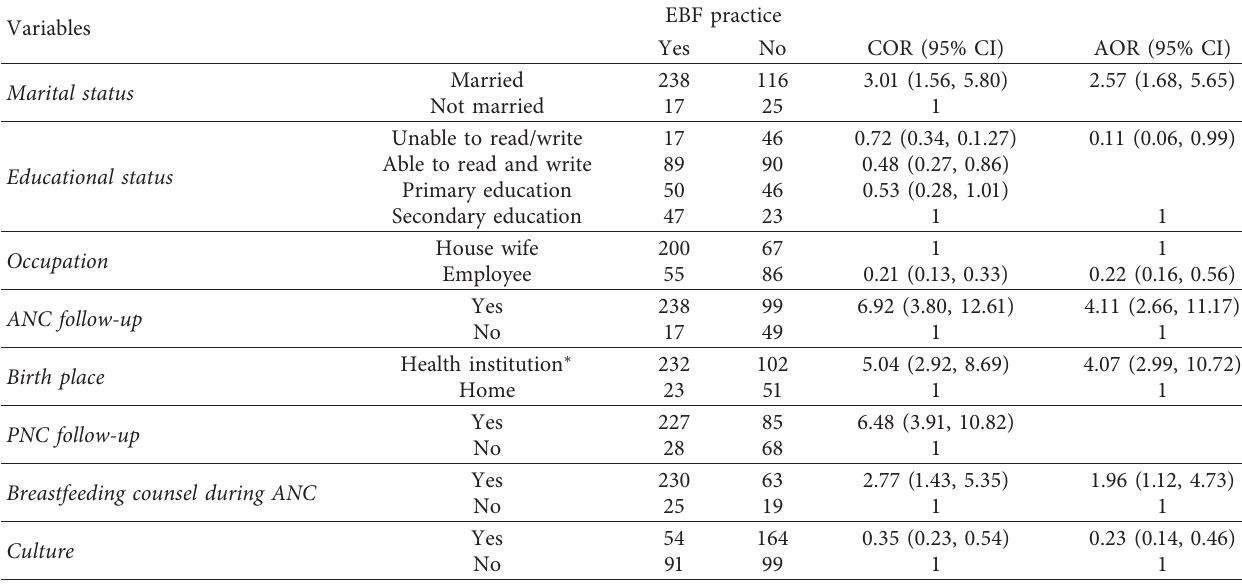
Table 4: Factors associated with the exclusive breastfeeding practice among mothers with children aged less than two years in Ethiopia,